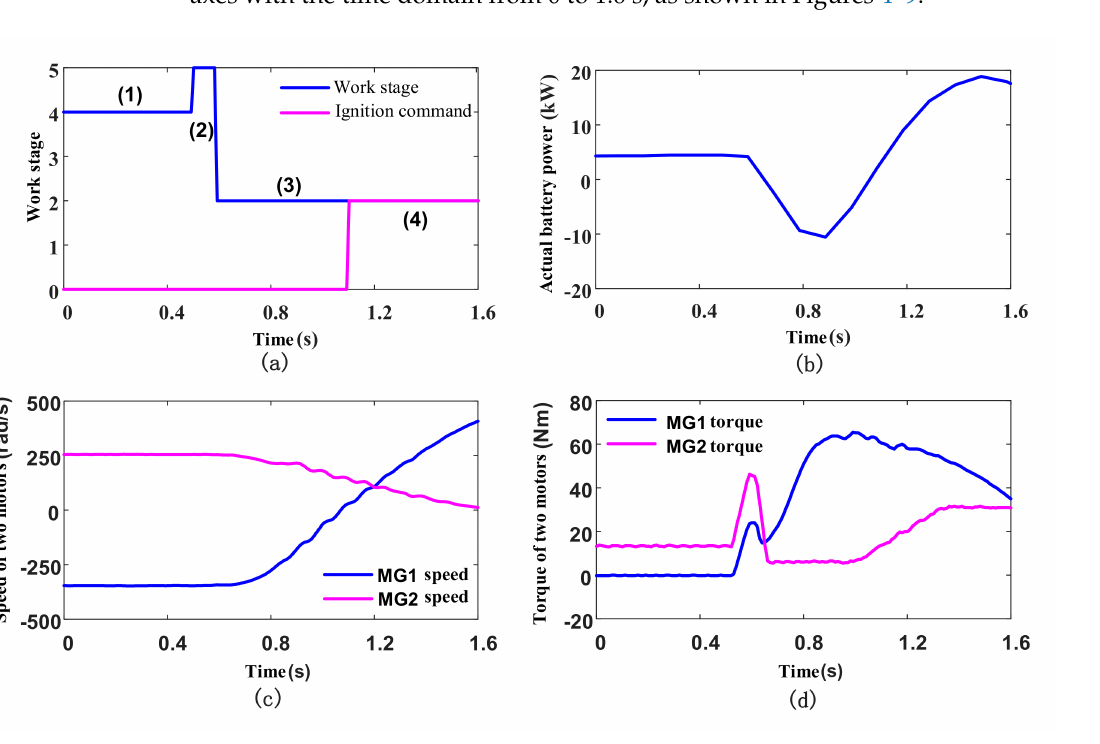
Figure 4. Battery motor characteristics of powertrain test bench system:( a ) work stage; ( b ) actual battery power; ( c ) speed of two motors; ( d ) torque of two motors.